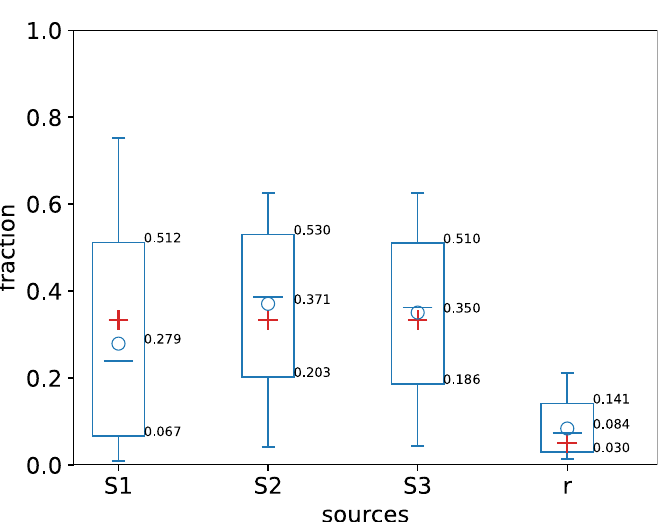
crosses show the true values used to create the simulated dataset.